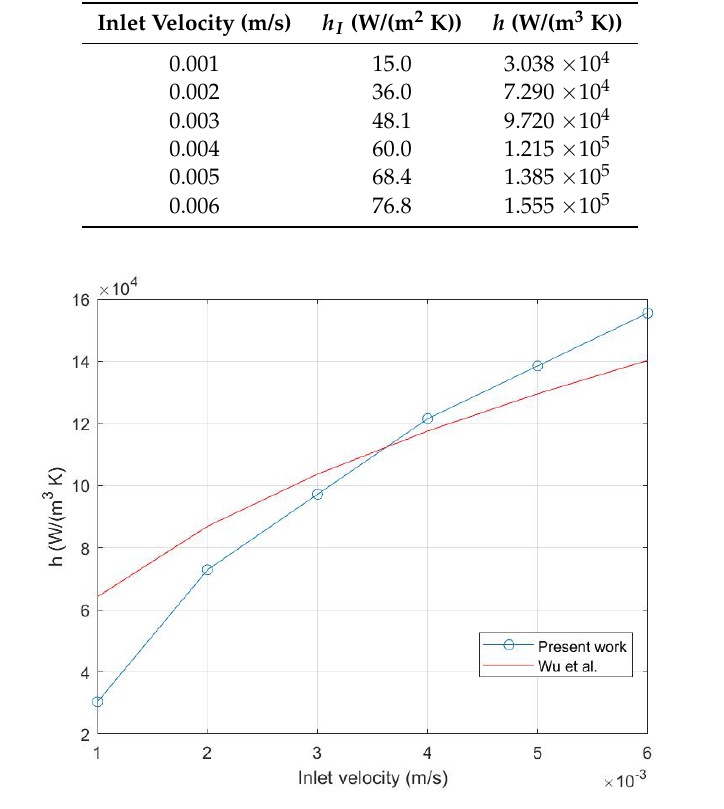
Figure 12. Comparison of the volumetric heat transfer coefficient obtained in the present paper with Wu et al. correlation